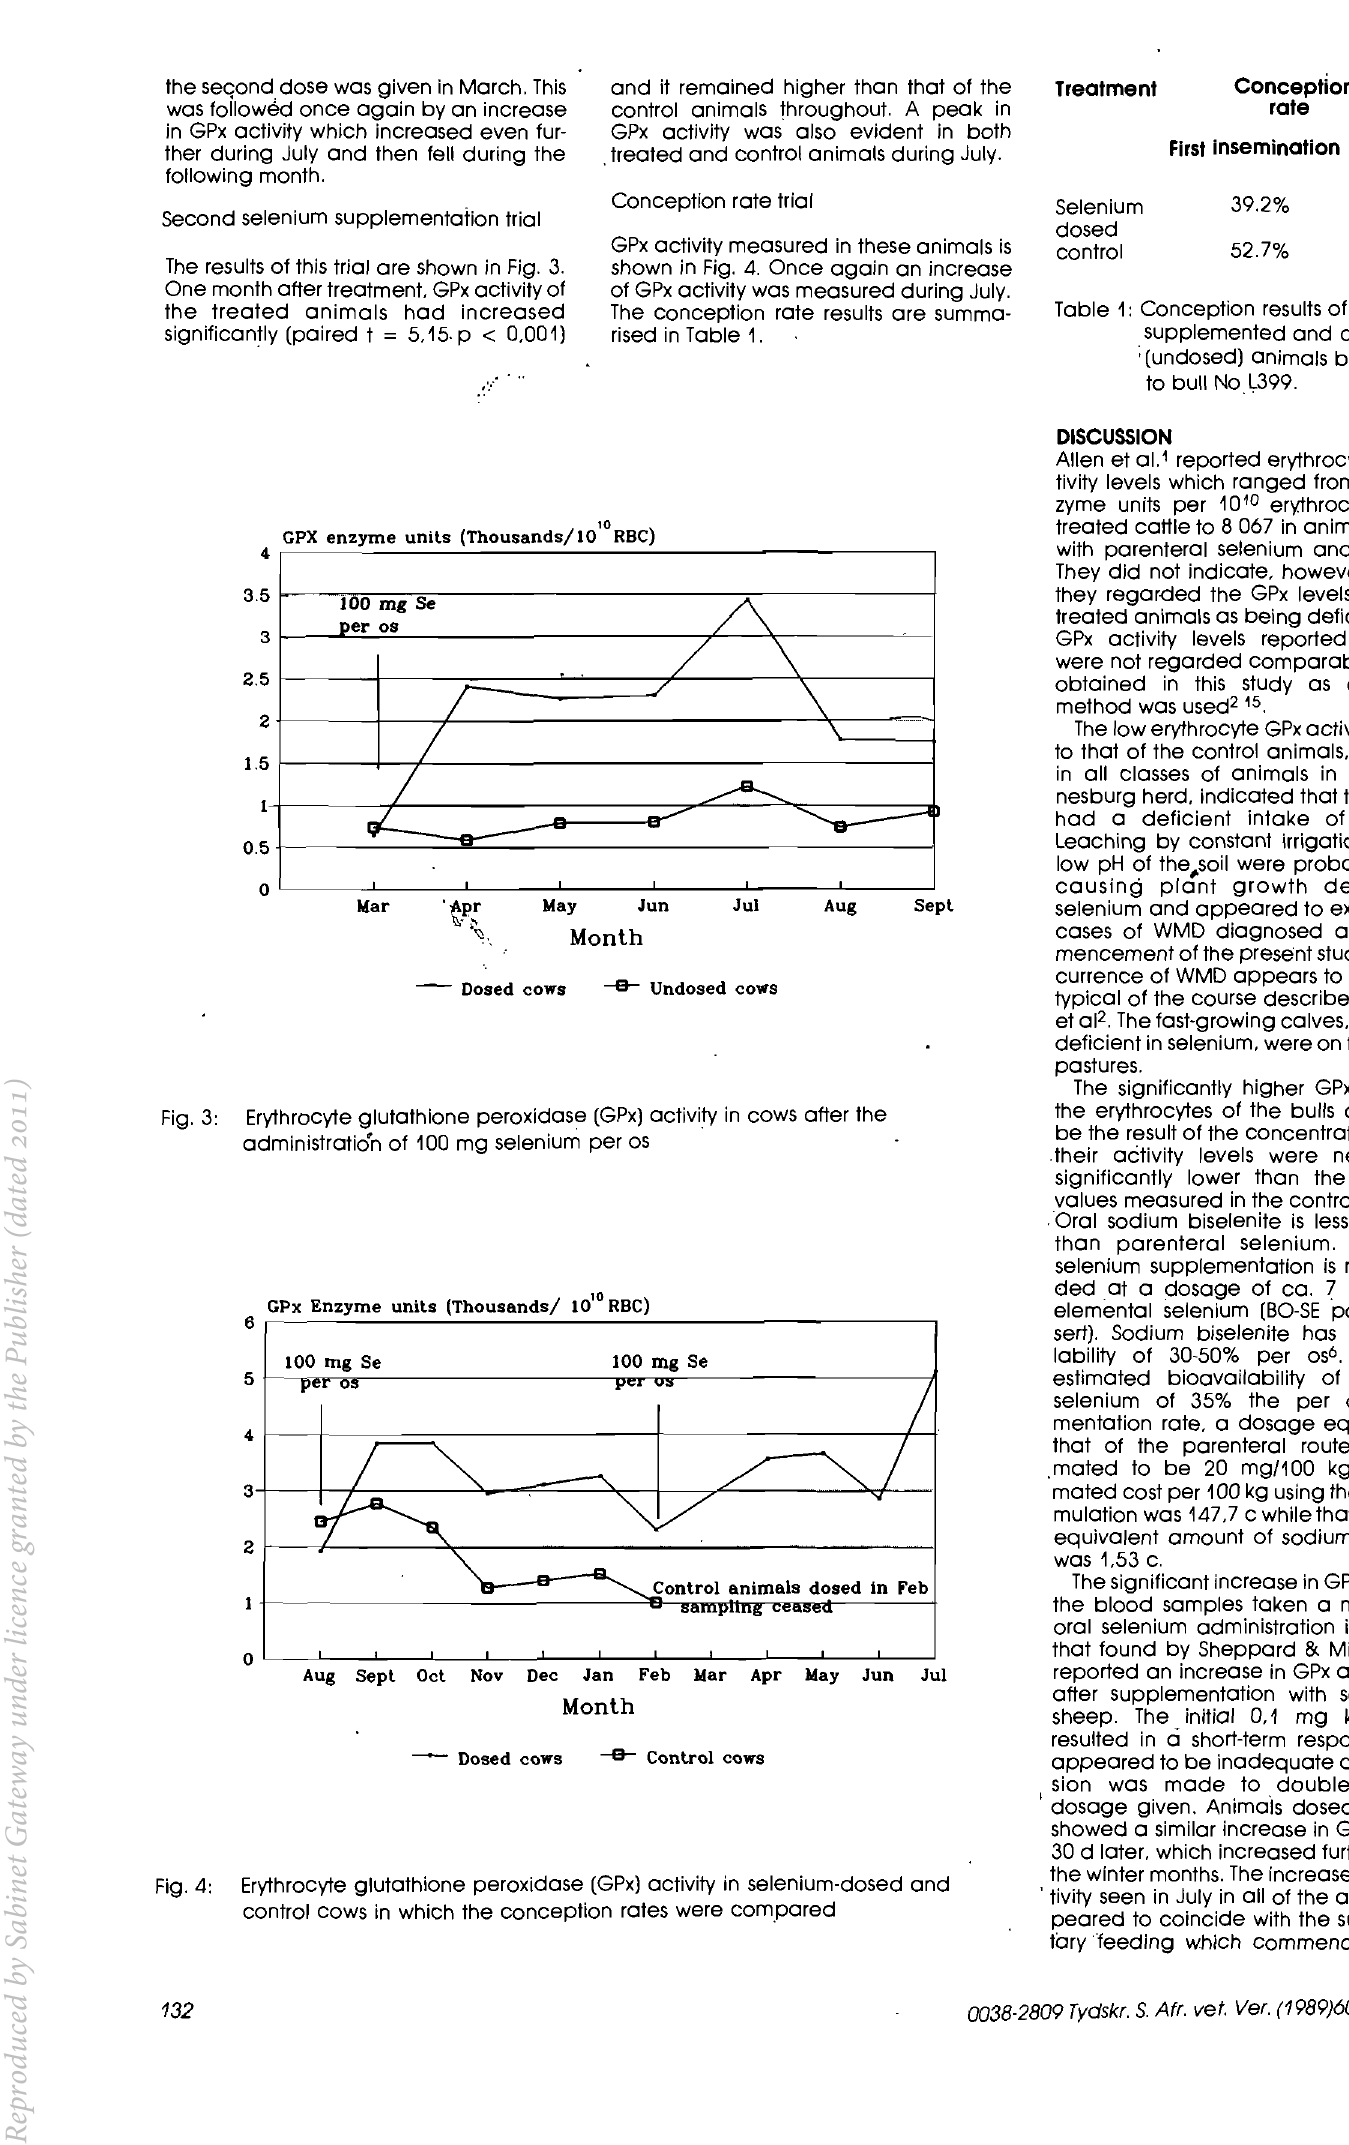
Table 1: Conception results of selenium supplemented and control ; (undosed) animals bred by AI to bull NoL399 . DISCUSSION Allen et 01. 1 reported erythrocyte GPx